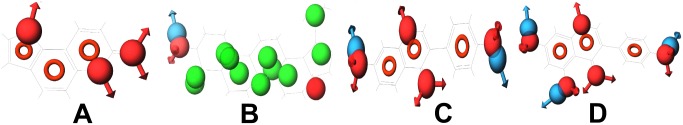
Compounds (with their pharmacophoric features) that target DNA topoisomerase 2.(A) Bakuchicin, (B) Betulinic acid, (C) Diadzein and (D) Genistein. These compounds do not show similar pharmacophoric features. Only diadzein is similar to genistein.